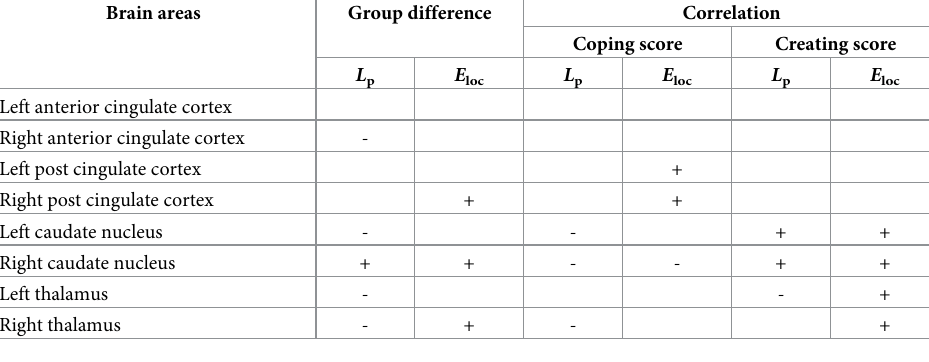
Table 6. Group differences and neural correlates (within the DMN) of CCH